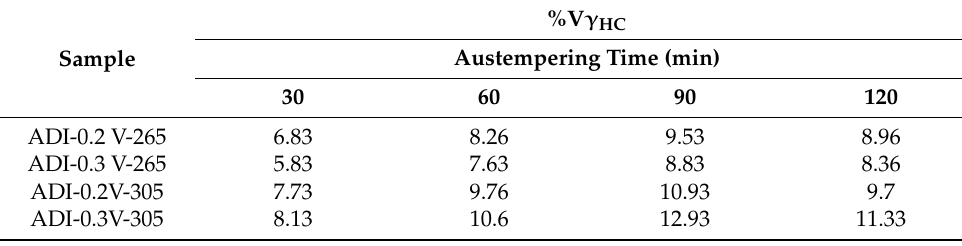
Table 4. The volume fraction of high-carbon austenite to 265 and 305 ◦ C for different austemper- ing